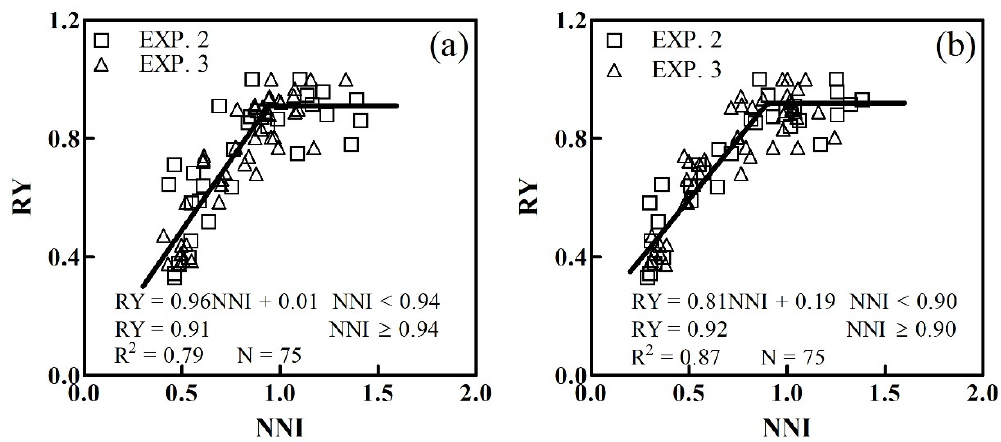
Figure 8. Prediction models for estimation of relative yield (RY) from NNI at the jointing ( a ) and booting ( b ) stages.